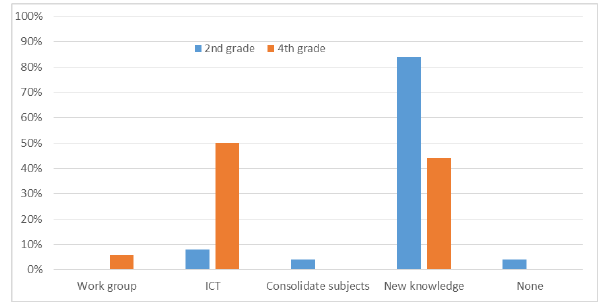
Figure 8: First cycle students’ perceptions about improved skills with geotechnologies